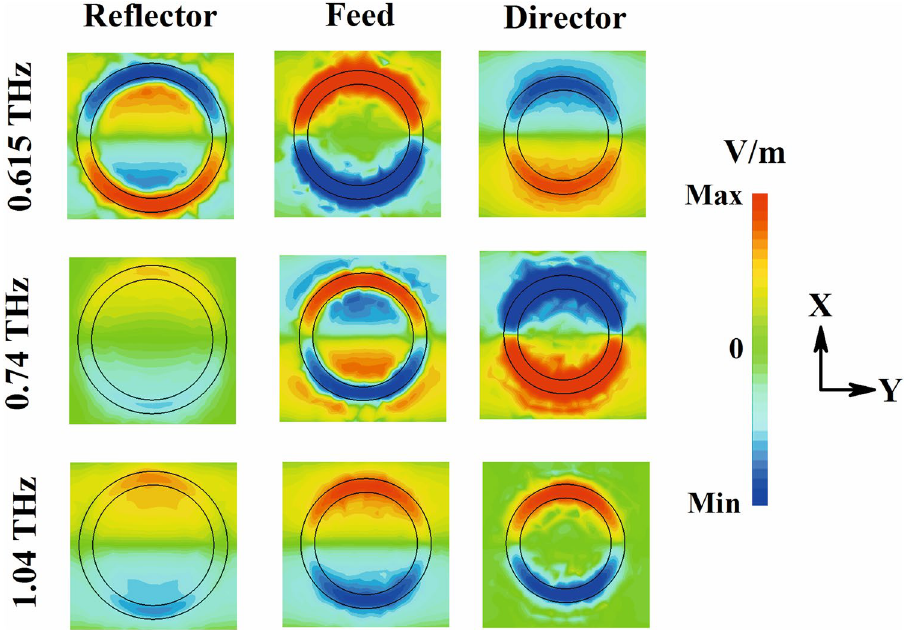
Figure 8. Z-component of electric field at bottom surfaces of three rings; Reflector (bottom), feed (middle) and director (top).